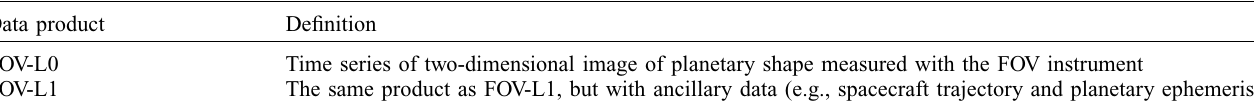
Table 2. Product list for the FOV instrument data.